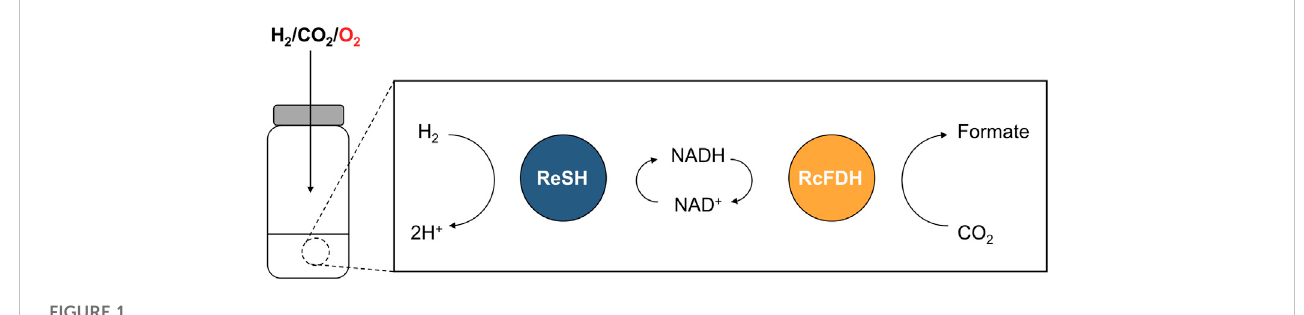
FIGURE 1 Schematic showing the NAD + -dependent cascade reaction of ReSH and RcFDH in the presence of O 2